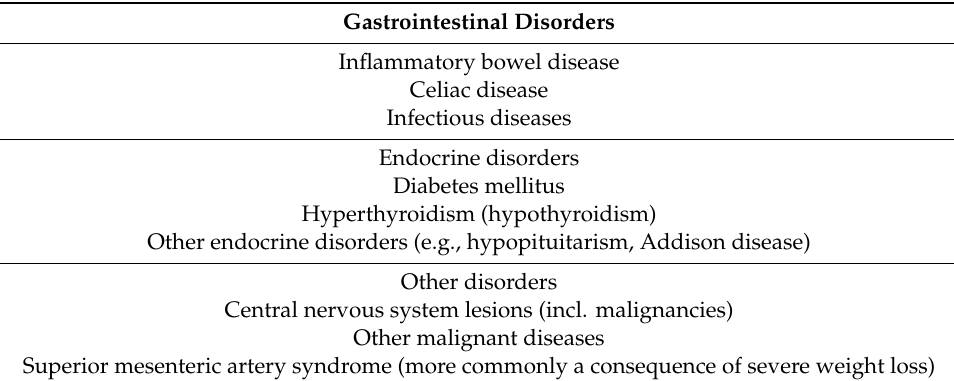
Table 3. Di ff erential diagnosis of childhood AN